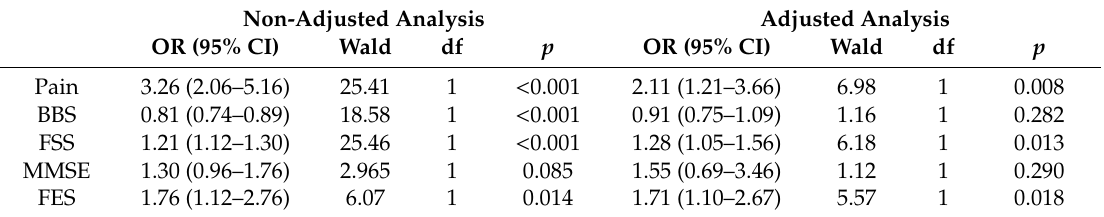
Table 4. Non-adjusted and adjusted analysis of risk factors a ff ecting the development of falling in NMOSD patients.